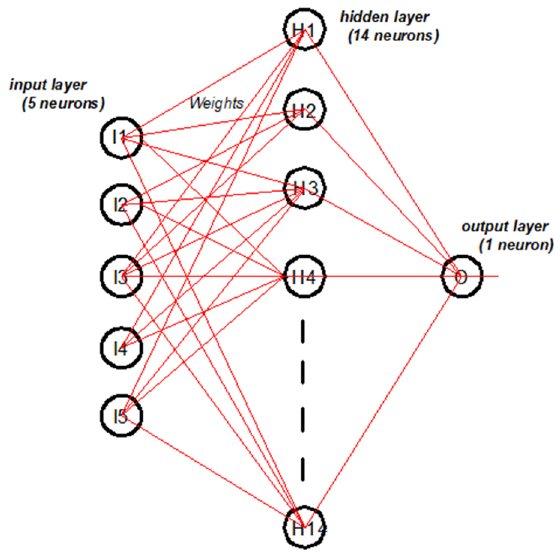
Figure 3. Artificial neural network processing.